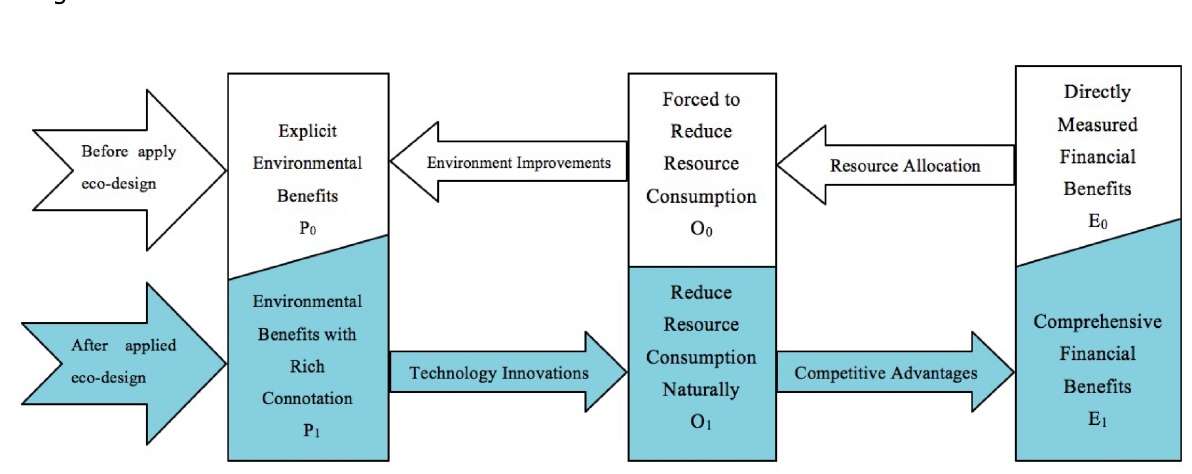
Figure 1. Mechanistic model of eco-design and products resources, economic and environmental benefits